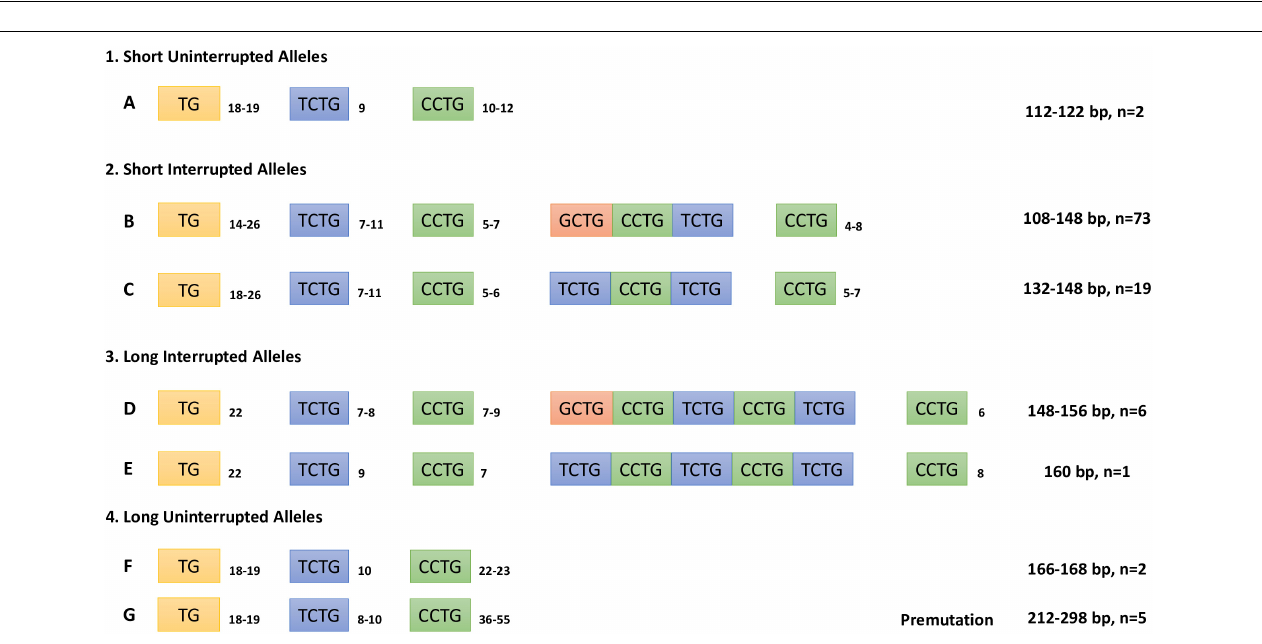
FIGURE 3 | Frequency and distribution of CNBP healthy range alleles in DM2-negative Italian individuals ( n = 378). Absolute number of alleles has been reported above the bars in the graph (total number of alleles = 756).